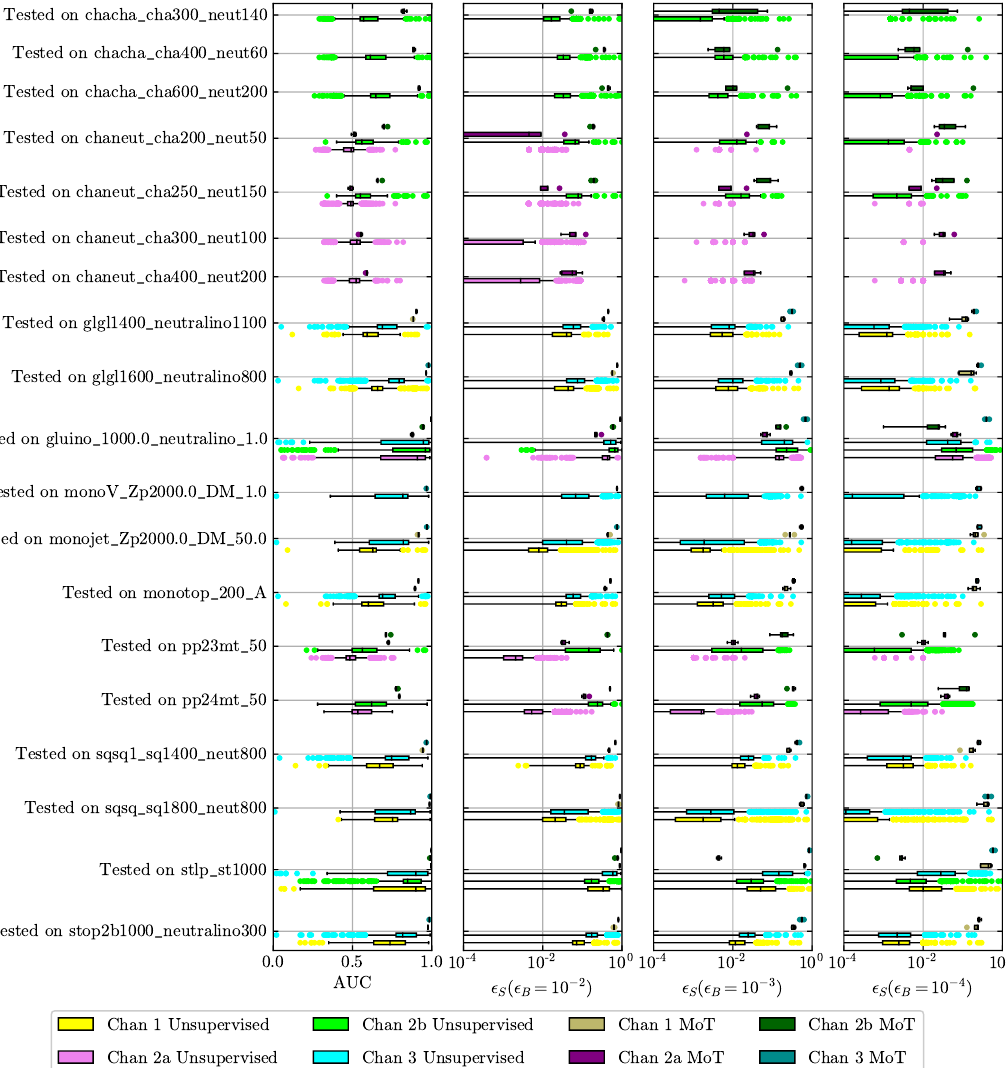
Figure 9 . The figure shows the results for AUC and (cid:15) S with multiple (cid:15) B ( 10 − 2 , 10 − 3 and 10 − 4 ) comparing the supervised methods trained from the mixture of theories (boxes above the middle lines) and the unsupervised methods (boxes below the middle lines). Chan X Unsupervised denotes the results for channel X from unsupervised methods, while Chan X MoT denotes the results for channel X from supervised methods. For each individual channel, the ML models above the central line correspond to the 5 endpoints of the dashed lines in figures 1, 5, 6 and